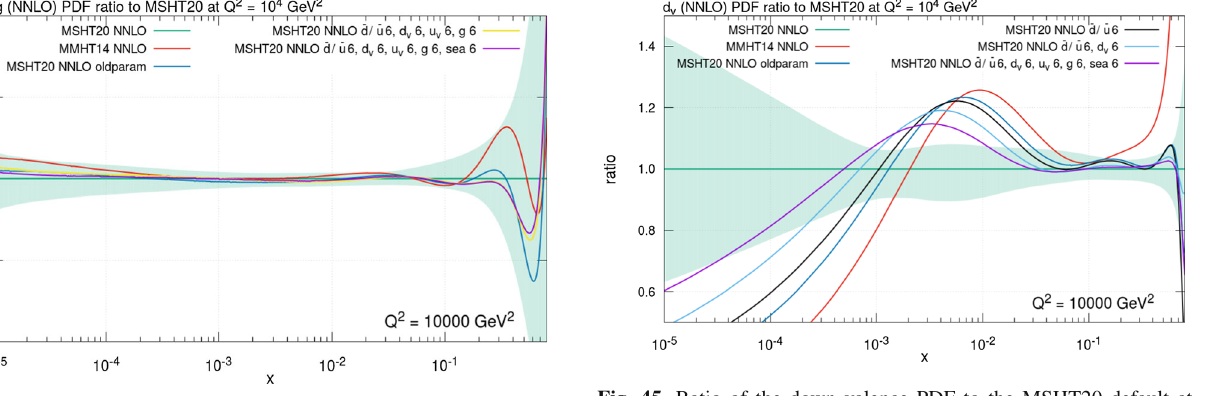
Fig. 44 Ratio of the gluon PDF to the MSHT20 default at Q 2 = 10 4 GeV 2 at NNLO showing how incrementing the old parameteri- sation to the new parameterisation affects the PDFs produced